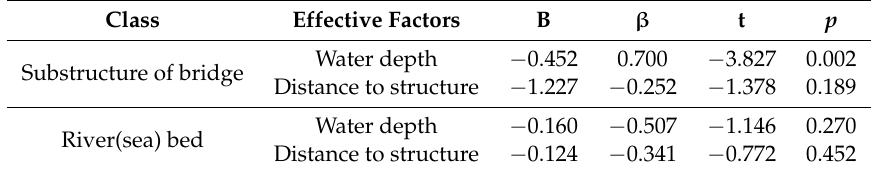
Table 4. Coefficient of effective